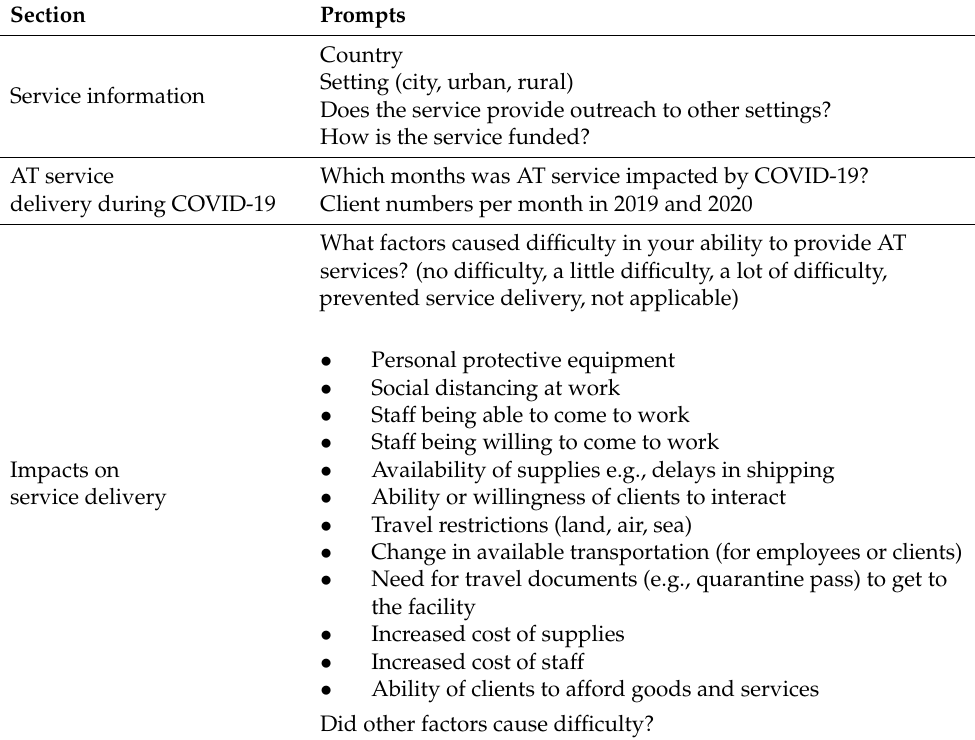
Table A1. Summarised survey question